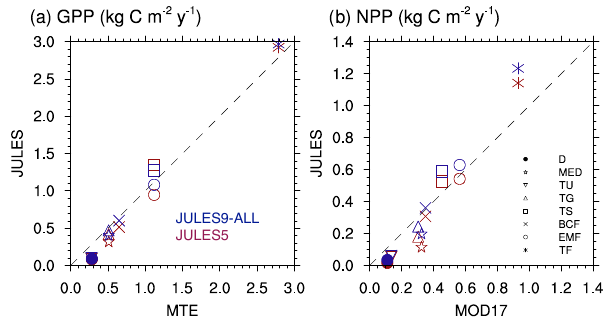
Figure 6. Annual GPP and NPP for the eight biomes shown in Fig. 3b. Biome abbreviations are D – deserts, M – Mediterranean woodlands, TU – tundra, TG – temperate grasslands, TS – tropi- cal savannahs, BCF – boreal and coniferous forests, EMFs – extra- tropical mixed forests, TF – tropical